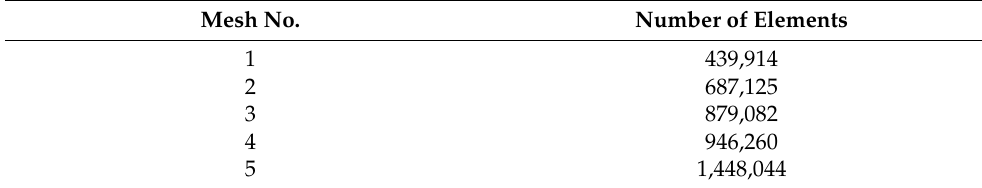
Table 3. The number of elements in the meshes. Mesh